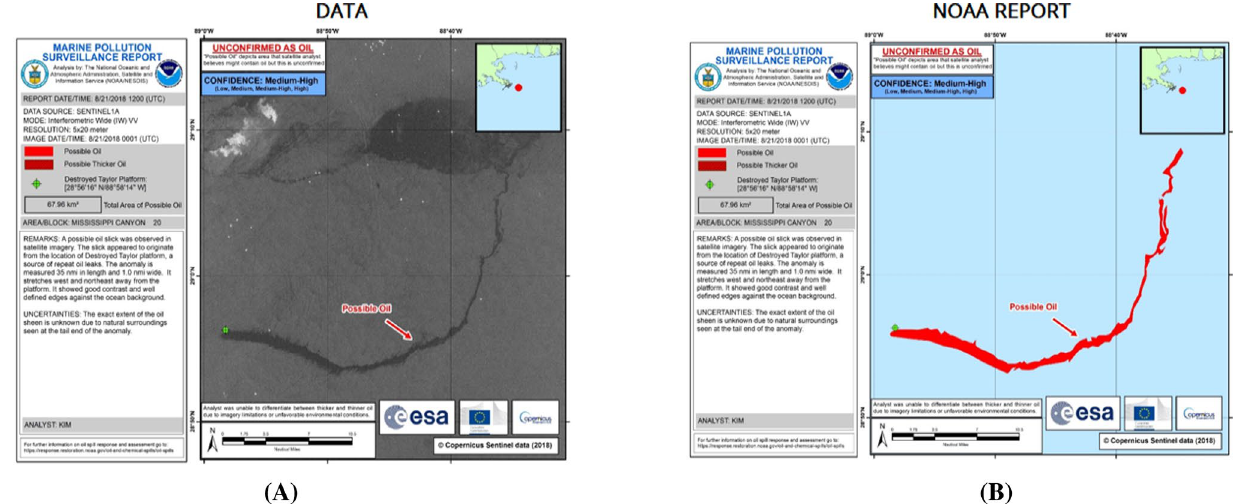
Fig. 7 NOAA’s report, where the oil slicks are presented in the original SAR image ( A ), and its corresponding polygon ( B ). Table 2 Acquisition dates for each scene in the Oil Spill dataset. Training images are in